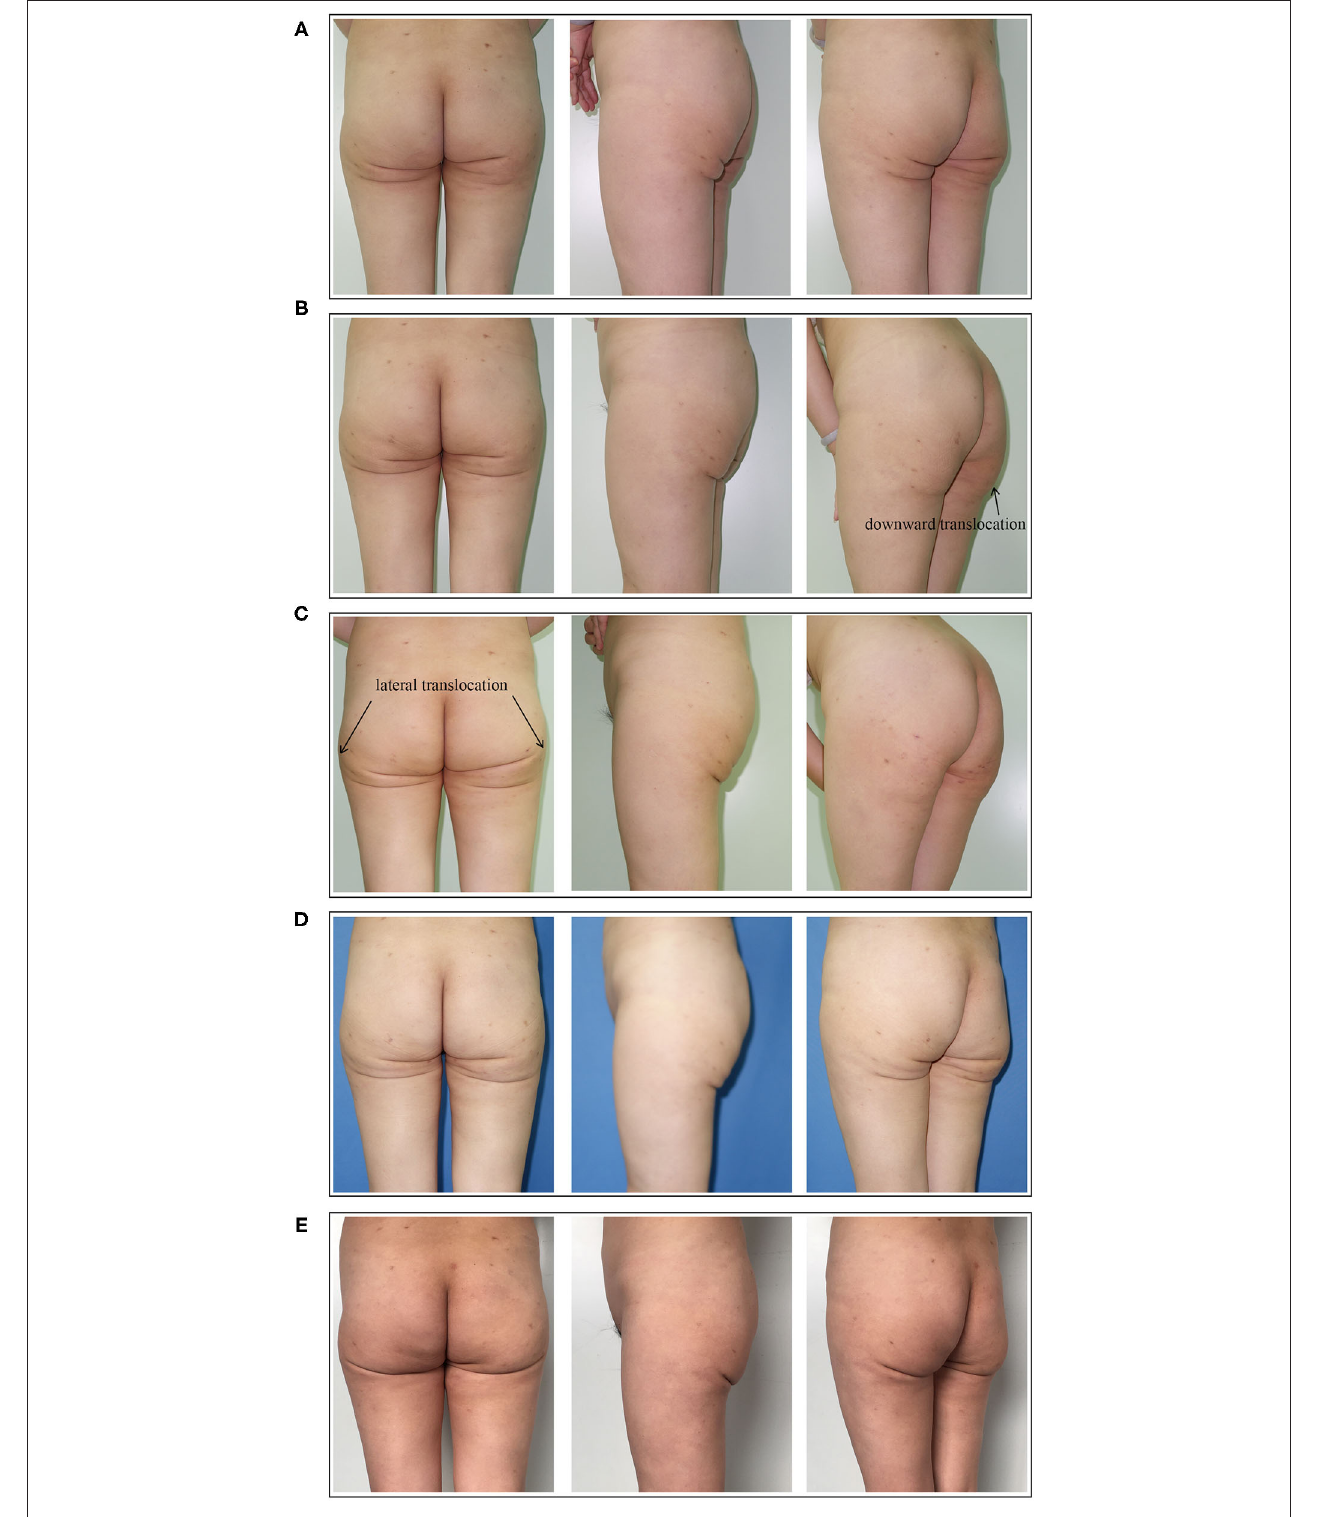
FIGURE 3 | (A) Postoperative view of the patient 4 months after the 1st reconstructive operation. Little improvement of the deformity was seen. (B) Postoperative view of the patient 3 months after the 2nd reconstructive operation. The multiple infragluteal folds on the left side were slightly improved. The arrow indicates that the downward translocation of fat and the convex deformity. (C) Postoperative view of the patient 3 months after the 3rd reconstructive operation. The gluteal contour